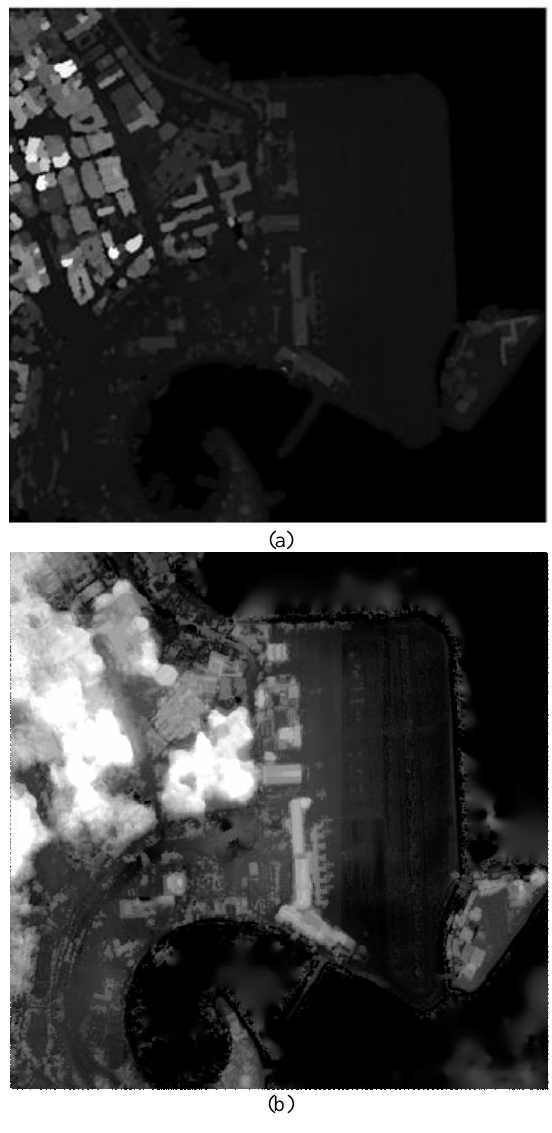
Table 3. standard deviation of tested sites points.